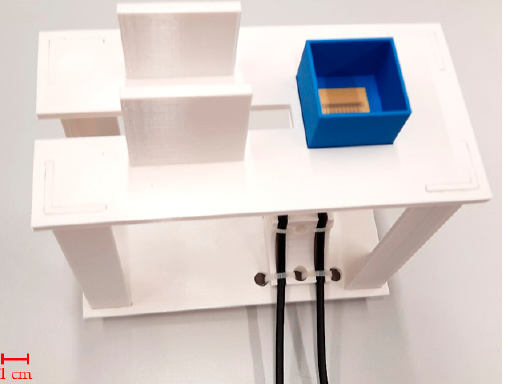
Figure 2. Tailor-made holder with MTM9 sensor in PLA box ready for measurement.